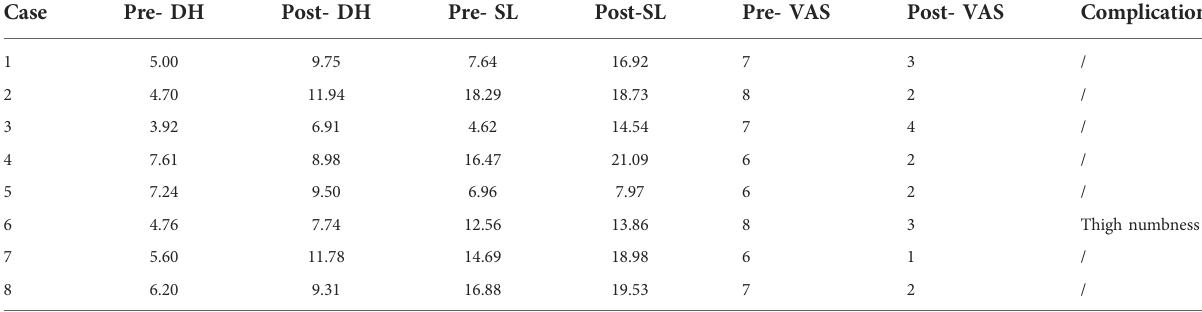
TABLE 2 Radiographic results and complications of the